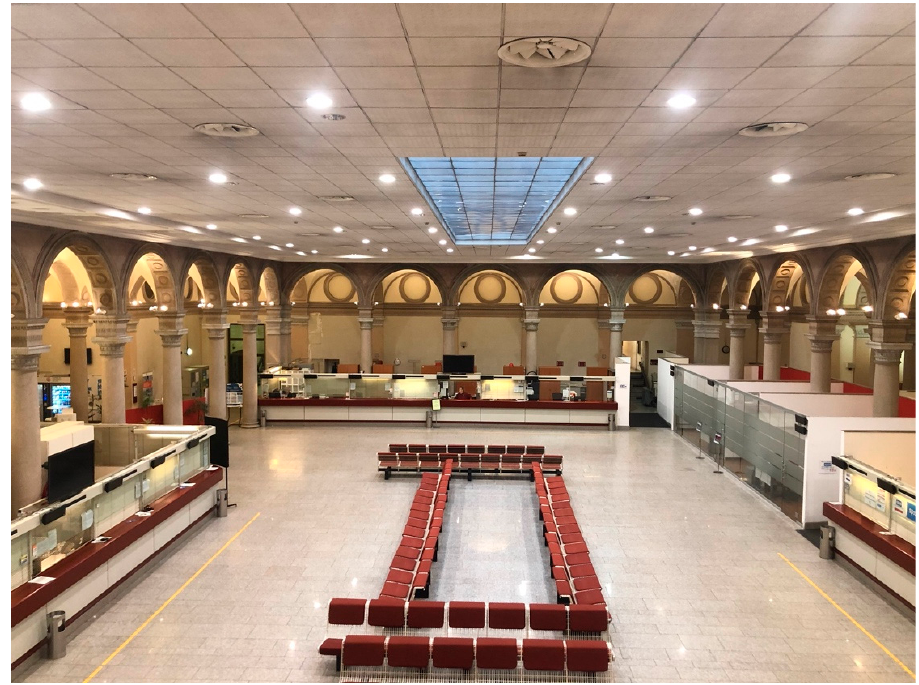
Figure 1. The space of the central hall before